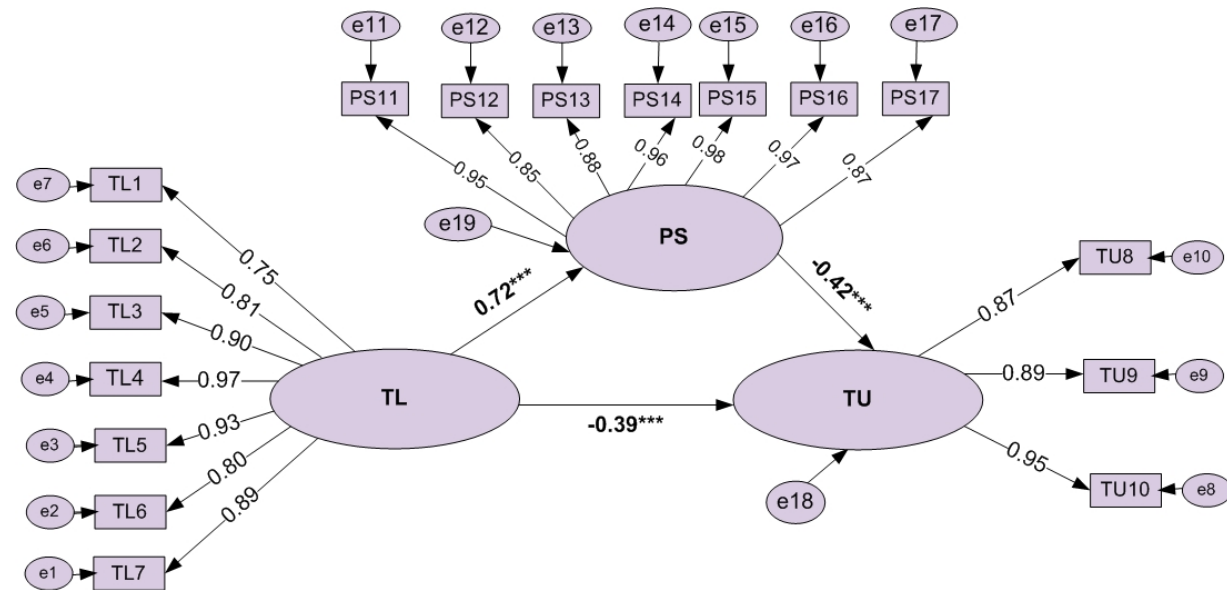
Figure 2. The structural model (developed by authors). *** p < 0.001. Table 3. The result of structural model (developed by authors).